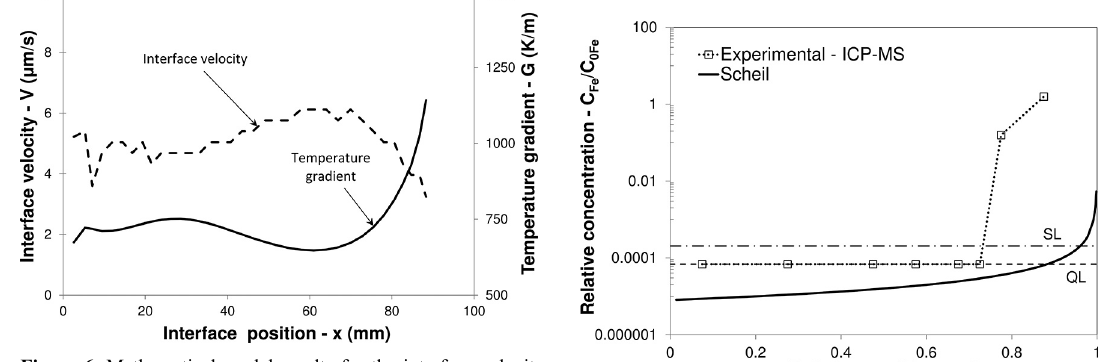
Figure 6. Mathematical model results for the interface velocity ( V ) and the temperature gradient ( G ) at the liquid adjacent to the solid-liquid interface as a function of the interface position along the axial direction.